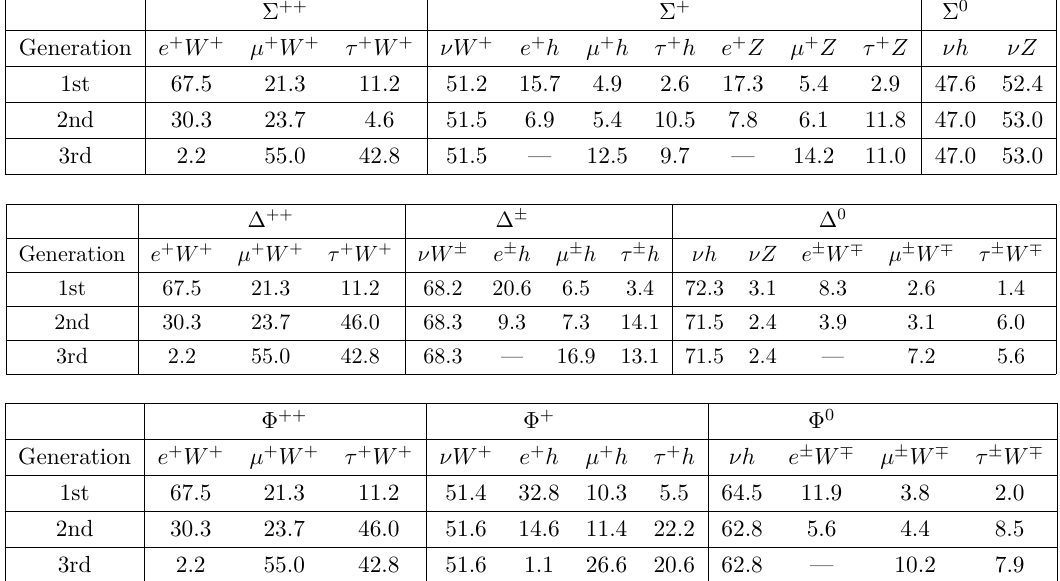
Table 7 . Branching fractions (in %) for relevant decay modes of all three generation doubly-, singly-charged and neutral exotics of triplet, quadruplet and quintplet. Branching fractions of less than 1% are